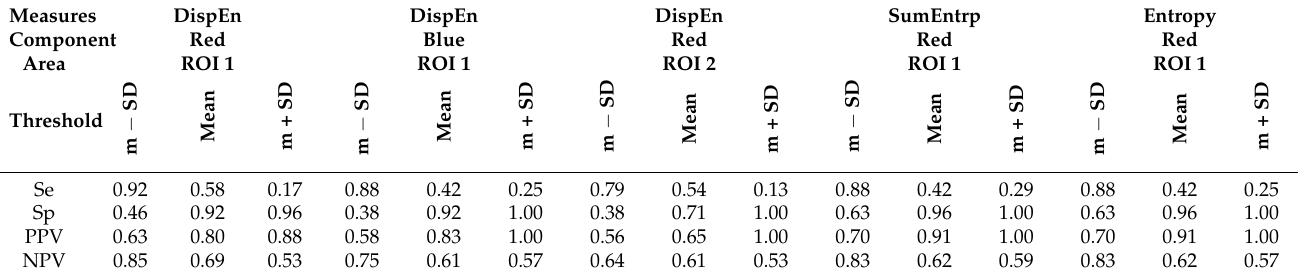
Table 1. The sensitivity (Se), specificity (Sp), positive predictive value (PPV), and negative predictive value (NPV) of distinguishing of light (L) and heavy (H) rider groups based on the selected entropy measures (DispEn—two-dimensional dispersion entropy, DistEn—two-dimensional distribution entropy) and the selected gray-level run-length matrix features (SumEntrp—summation entropy, entropy) for selected color components (red, blue) and areas (ROI 1—the withers area, ROI